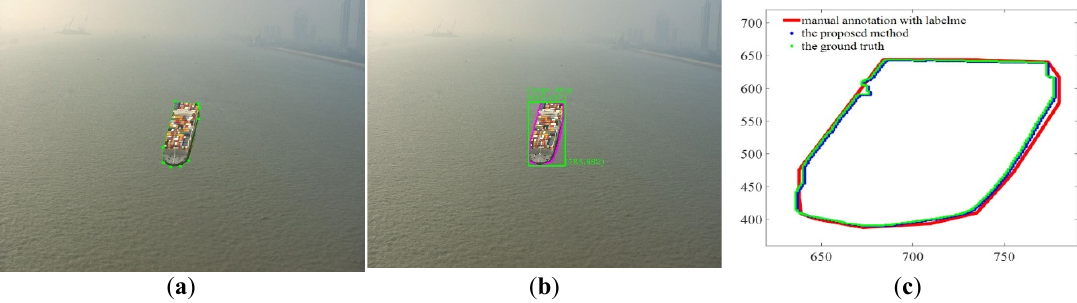
Figure 12. Manual annotation and the proposed annotation method: ( a ) manual annotation method; ( b ) the proposed annotation method; ( c ) the results of the annotation.